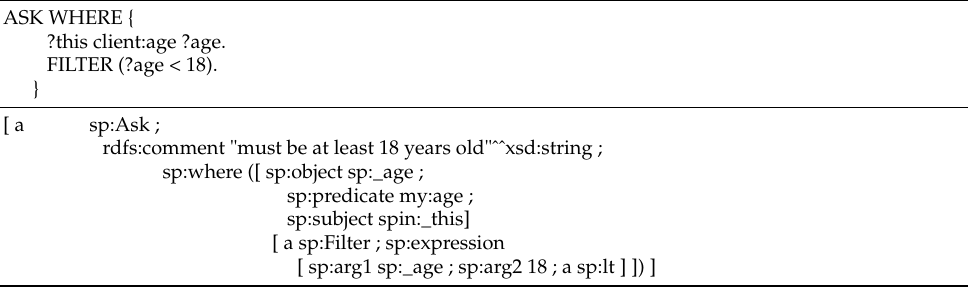
Table 8. SPARQL Query and SPIN